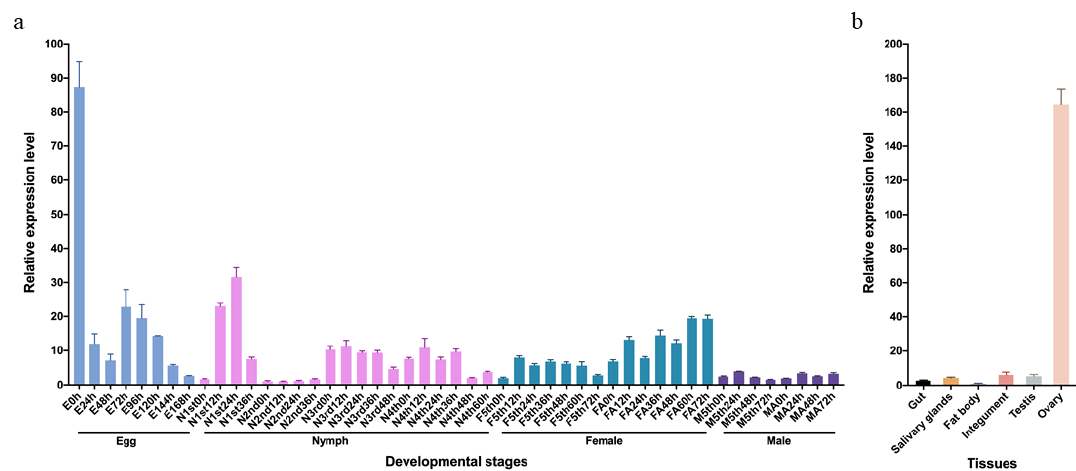
Figure 1. Sequence analysis of NlFoxN1 . ( a ) Exon-intron analysis of NlFoxN1 was carried out by GSDS2.0. ( b ) Alignment of amino acid sequences of forkhead domain (FHD) from 12 species was carried out by DNAMAN.